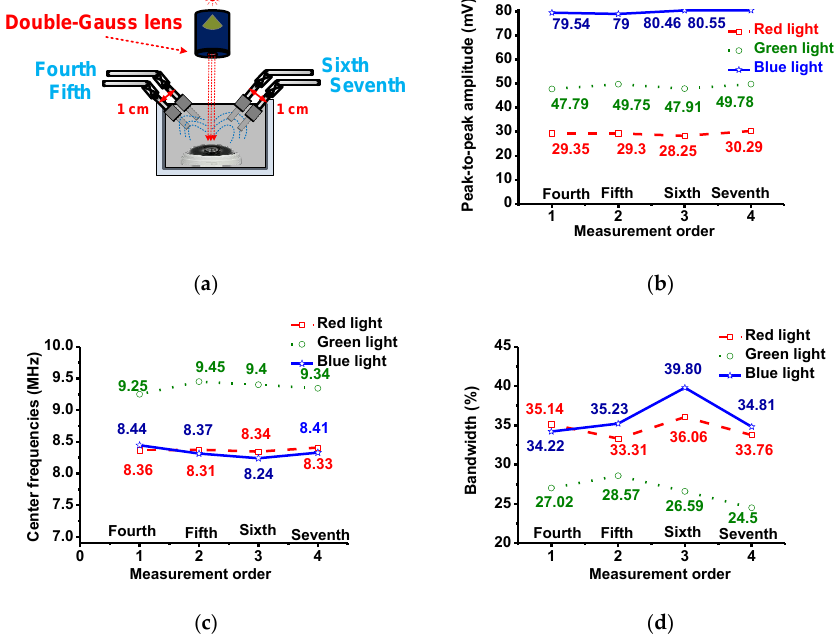
Figure 13. ( a ) Experimental setup when the transducers were placed in the left and right sides and ( b ) peak-to-peak amplitudes; ( c ) center frequencies; and ( d ) −6 dB bandwidths of the echo signal.